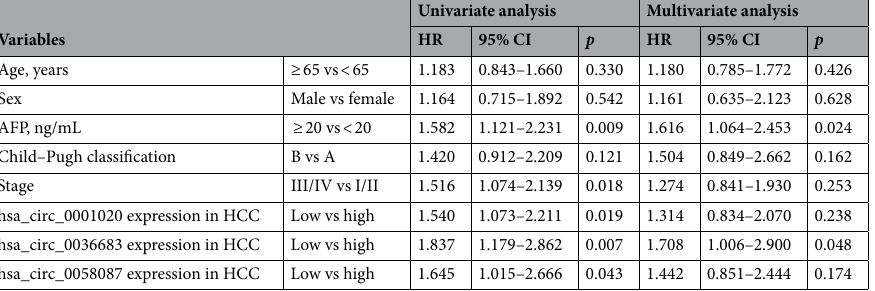
Table 3. Univariate and multivariate cox proportional hazards regression analysis for overall survival. HR hazard ratio, CI confidence interval, AFP alpha-fetoprotein.